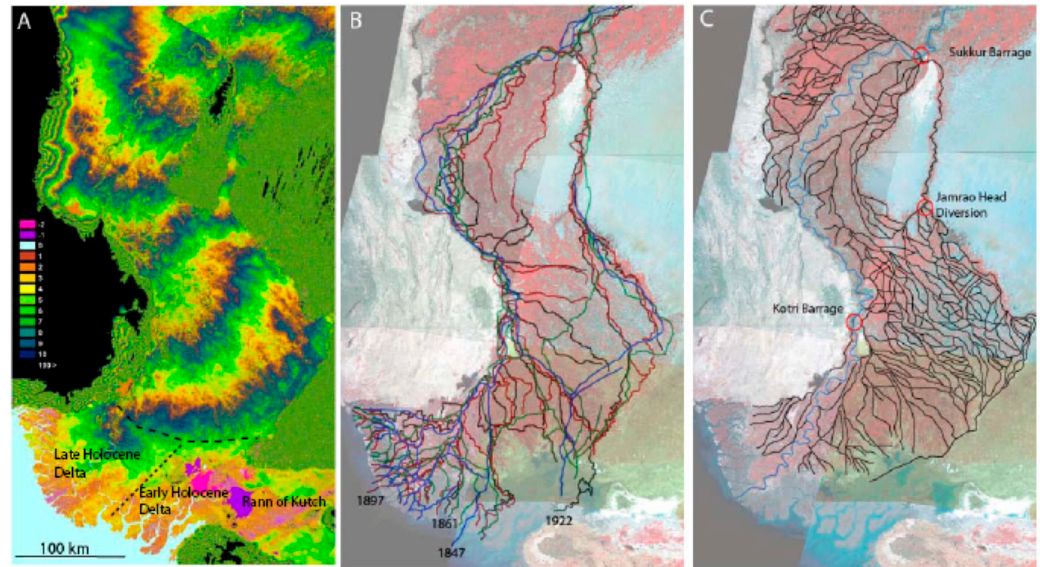
Figure 10. ( A ) Morphology of the Indus alluvial mega-ridge and delta (after [6,9,102]) displayed with SRTM altimetry, binned at 1 m vertical intervals, starting at sea level (light blue), then 1 color per 1 m interval, with colors cycled every 10 m, to a height of 100 m, then black. Topography below mean sea level is in shades of pink. Extent of the Indus delta is indicated by long dashed black line and its early Holocene vs. late Holocene sectors are separated by short-dashed line. ( B ) Historical location of distributary channels and ( C ) Irrigation channel system with main water distribution stations.